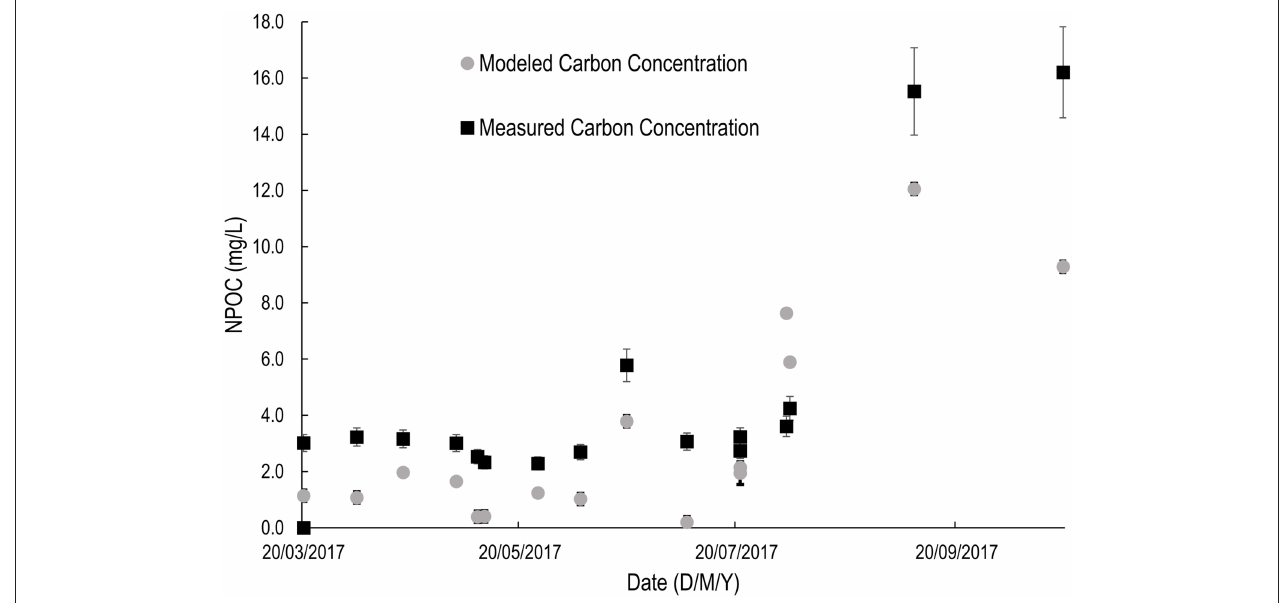
FIGURE 7 | Modeled (gray) and measured (black) DOC concentrations for Reynolds Creek streamwater, based on outcomes of the proportional-mixing model. Measured concentrations displayed with 10% analytical error, which is conservative: actual measurement errors may be